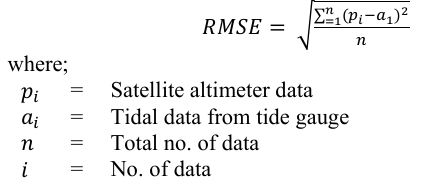
tidal data. The RMSE value of 0.062 m is also exhibited in the figure.